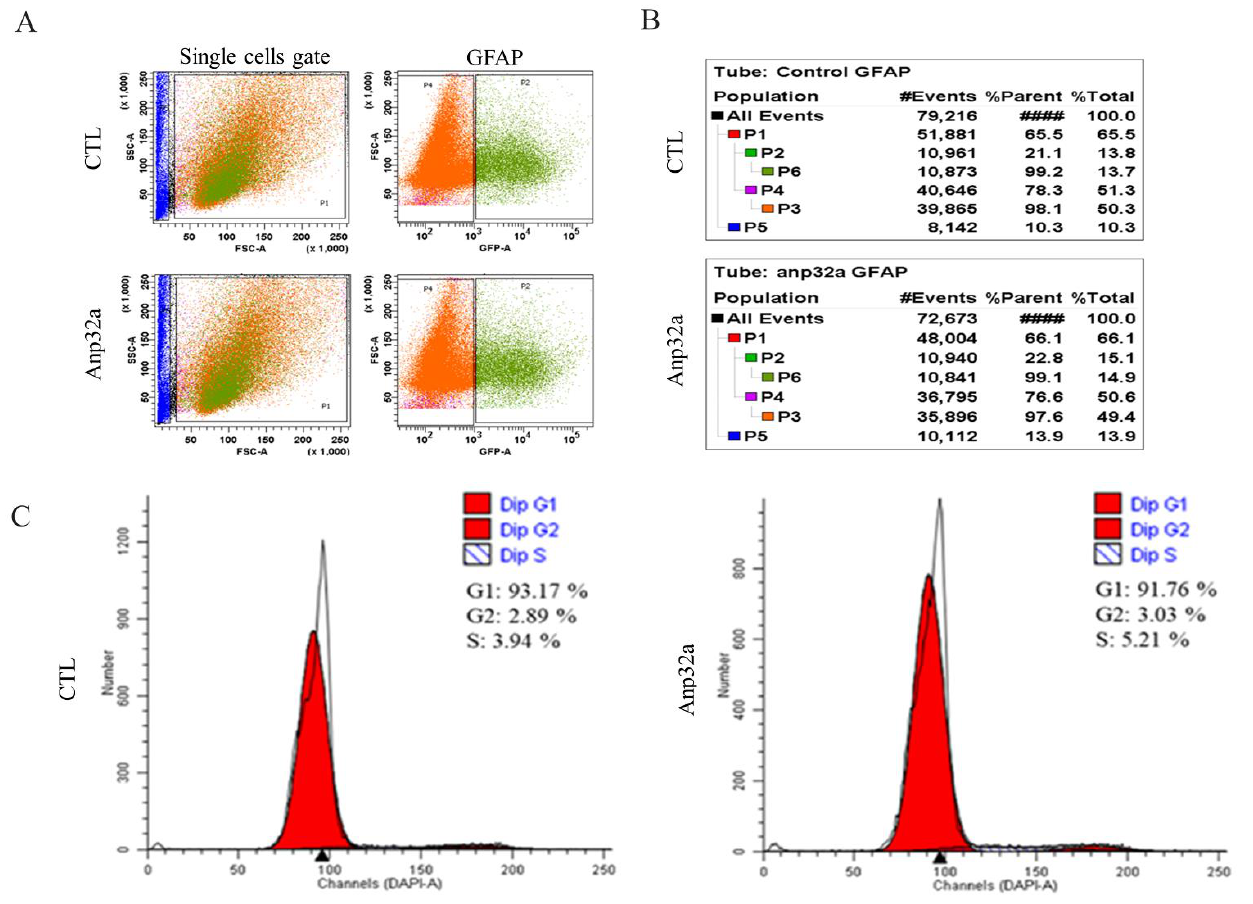
Figure 7. Overexpression of Anp32a in SCI embryos of zebrafish could induce the active proliferation of radial glial cells around the SCI site. Fluorescence-activated cell sorting (FACS) and a cell cycle analysis of radial glial cells in Anp32a -overexpressing SCI embryos of zebrafish were performed. Anp32a mRNA was microinjected into one-cell stage embryos from Tg(gfap:GFP) zebrafish, followed by SCI at 48 hpf and DAPI staining at 24 hpi. ( A ) Scatter profiles of Anp32a -overexpressing Tg(gfap:GFP) SCI-embryonic cells. All analytic cells were gated at P1; GFP-positive cells were gated at P2; DAPI-labeled-positive cells were gated at P6; GFP-negative cells were gated at P4. ( B ) Typical FACS dataset. The number shown in the right corner is the percentage of proliferated cells at each gate relative to the total examined cells in each group. ( C ) Cell cycle analysis from DAPI-labeled-positive cells shown on P6.